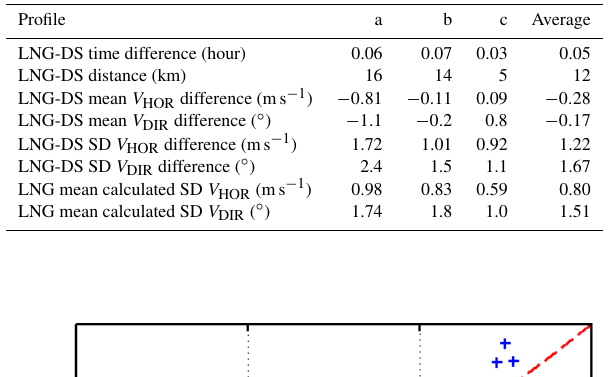
Figure C3. Comparison of the measured and calculated relative er- rors (standard deviation) on the particle backscatter coefficient.